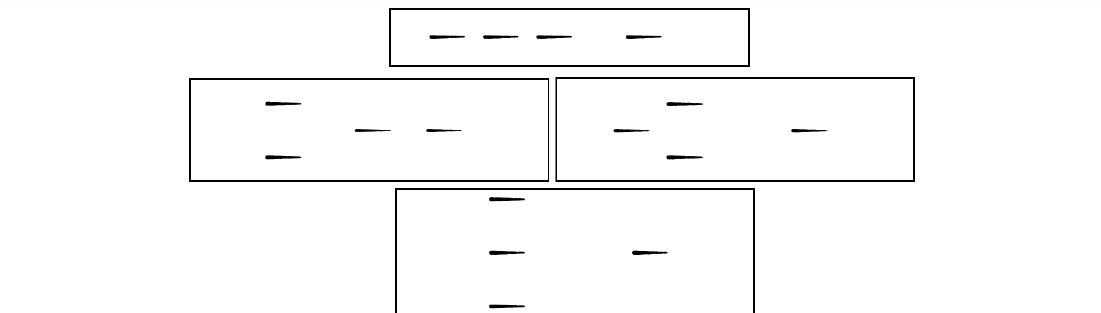
Figure A1. Configurations for two leading swimmers.